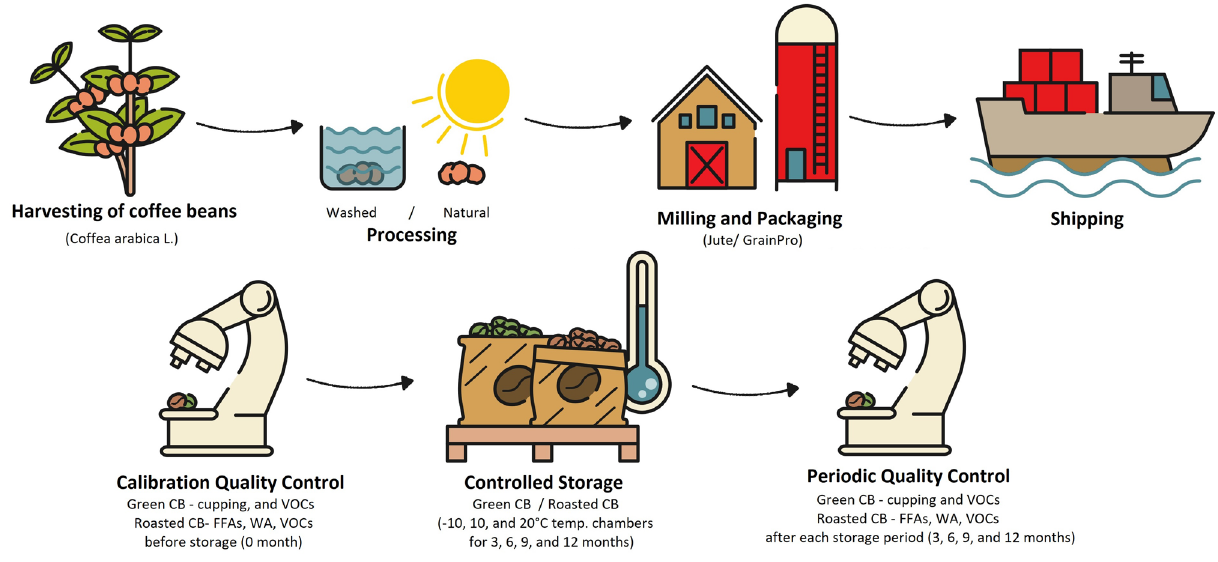
Figure 1. Illustration showing the process that the coffee beans have gone through from picking to